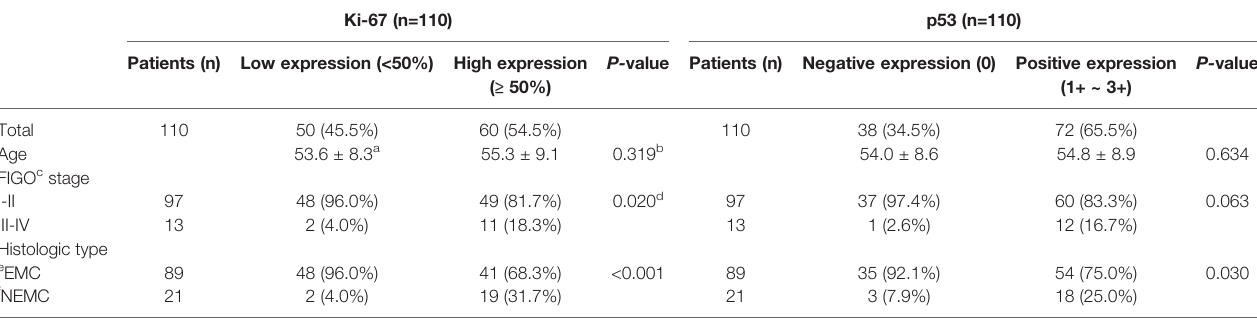
a Data are mean ± standard deviation. b T-statistical test. c FIGO, International Federation of Gynecology and Obstetrics. d Chi-square test. e EMC, Endometrioid carcinoma. f NEMC, Non-endometrioid